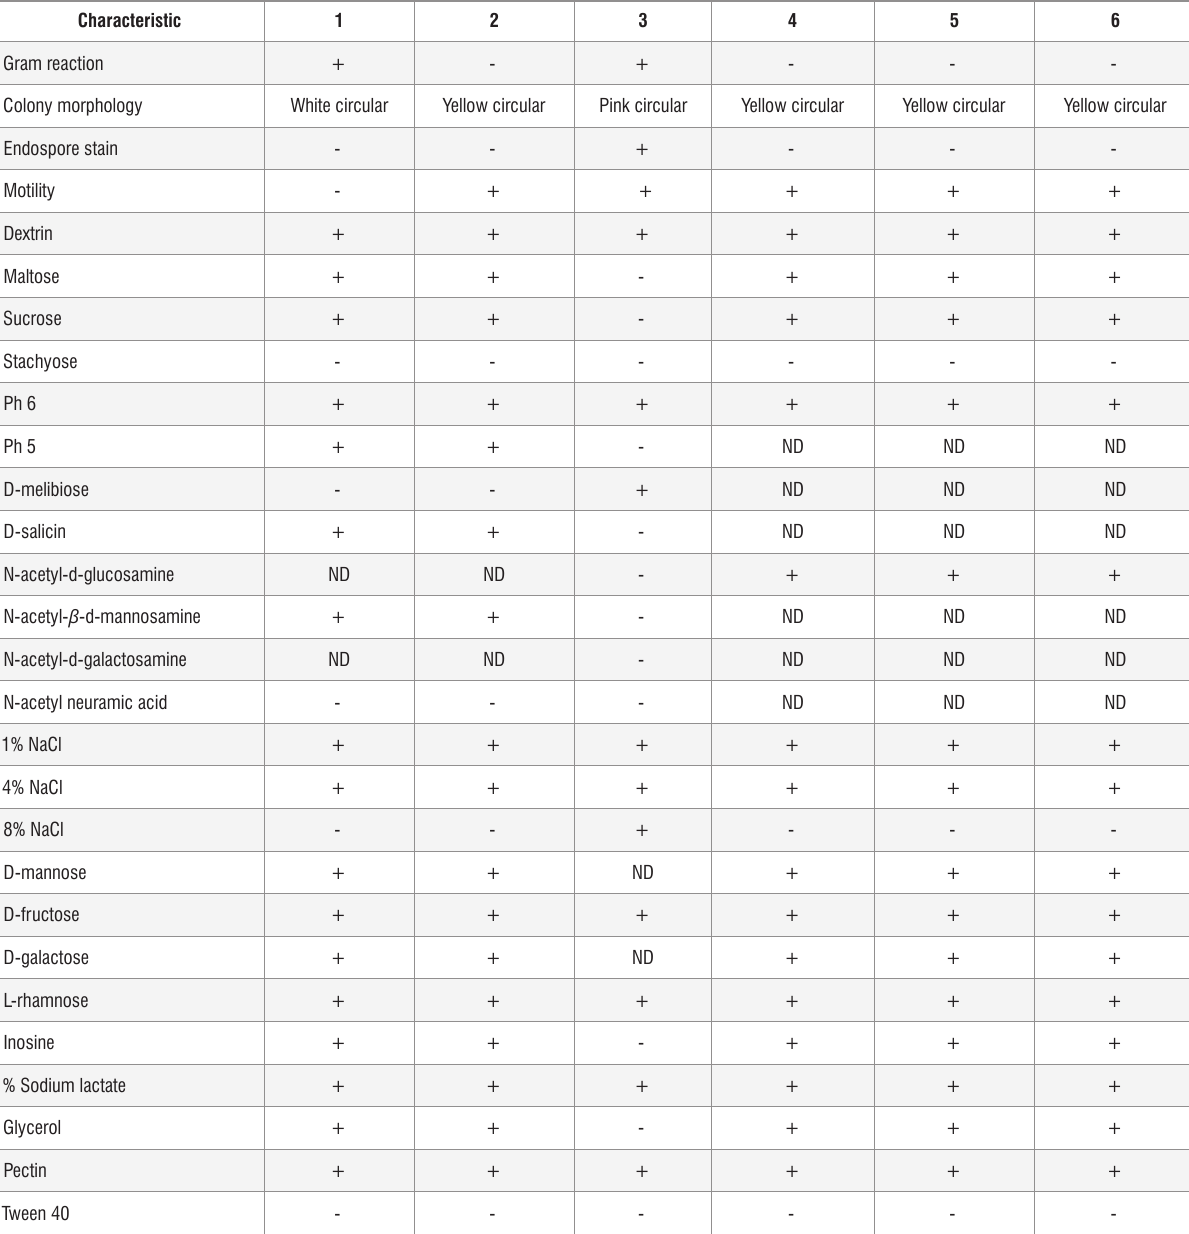
Table 1: Summary of phenotypic characteristics of bacterial endophytes isolated from Pellaea calomelanos Characteristic